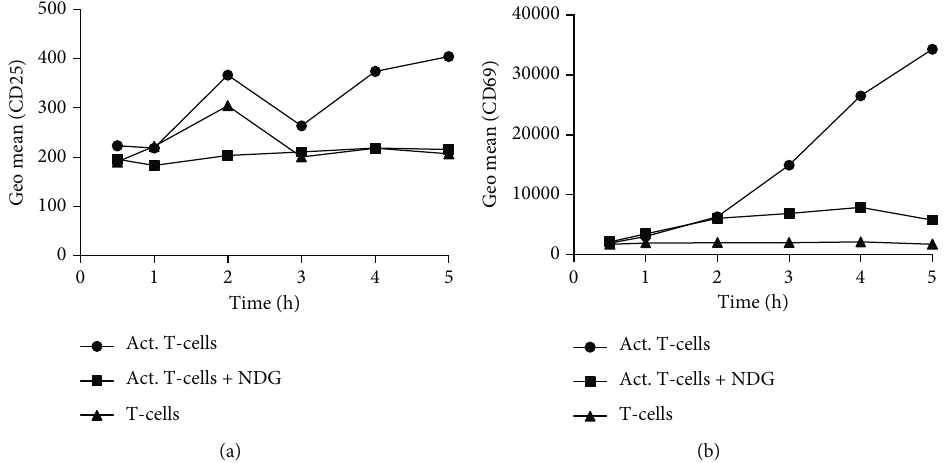
Figure 2: CD25 and CD69 expression on CD3 + T-cells during 0.5 – 5 hours coculture with NDG. (a) The geometric mean of CD25 on T- cells, activated T-cells, and activated T-cells cocultured with NDGs for 0.5 – 5 h. (b) The geometric mean of CD69 on T-cells, activated T- cells, and activated T-cells cocultured with NDGs for 0.5 – 5 h. Graphs show the median of 5